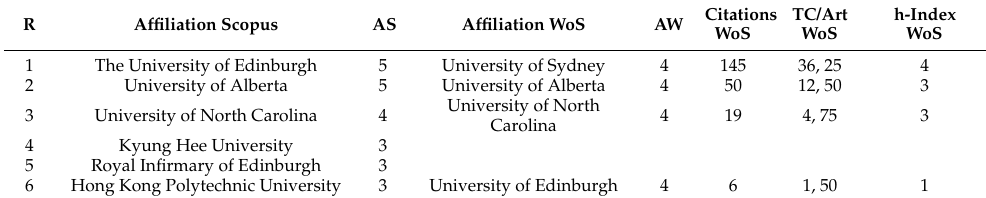
Table 4. Most relevant affiliations (Scopus and WoS).